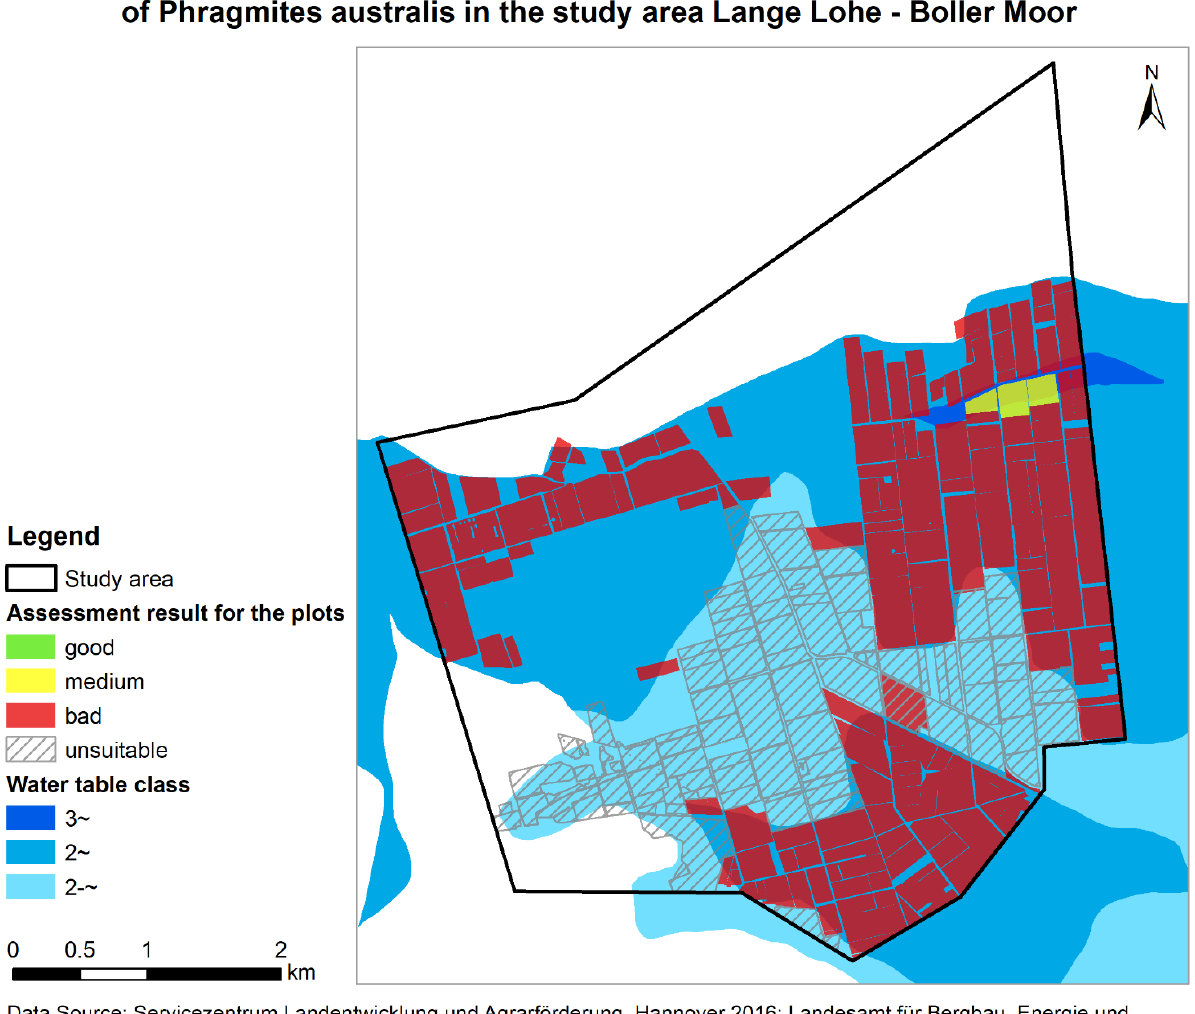
Figure 2. Example map visualisation of the evaluation of groundwater level in the study area Lange Lohe - Boller Moor for Phragmites australis